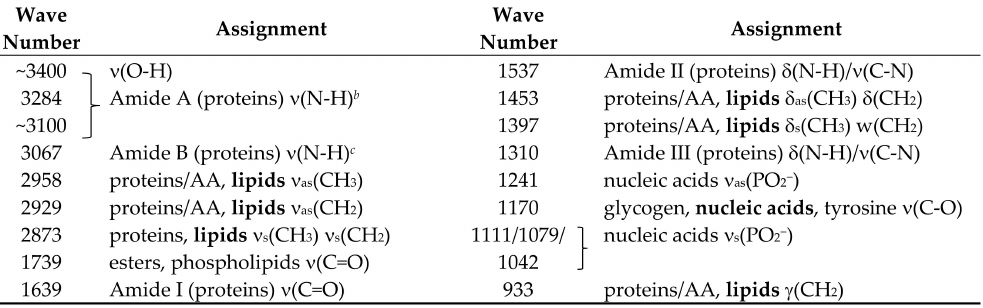
Figure 2. Cluster analysis of ASD (A; overlined in blue) and control (C; highlighted using the red color) groups’ blood serum IR spectra, according to the Ward’s method, using squared Euclidean distances. Table 2. Assignments for the major bands in the FTIR spectrum of blood serum a